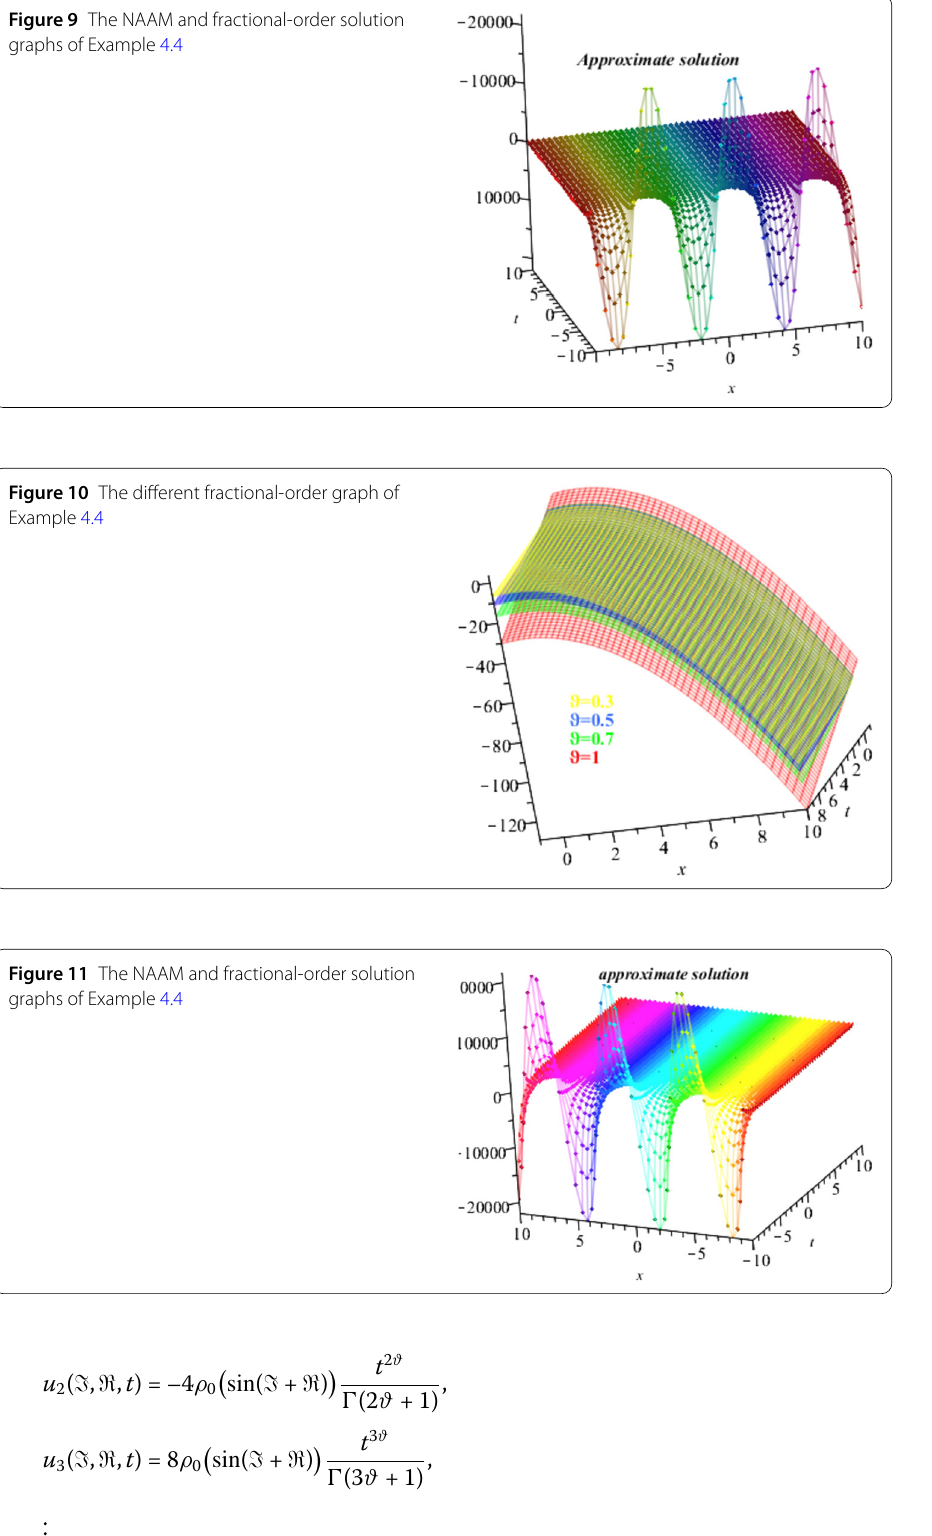
Figure 9 The NAAM and fractional-order solution graphs of Example 4.4